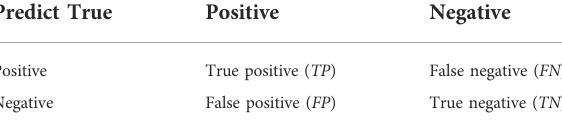
TABLE 1 Classi fi cation determination.